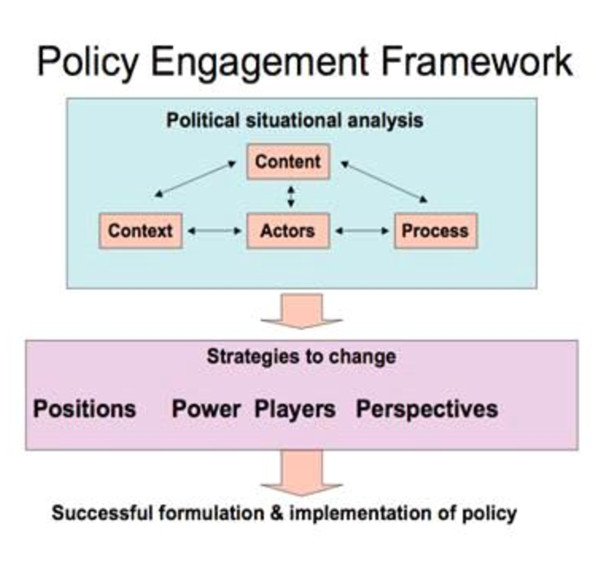
Policy Engagement Framework. Buse K, et al:2008 [39].